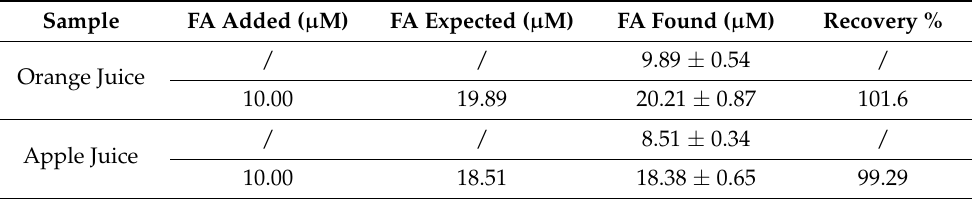
Table 3. Real sample analysis of FA using PE/CuO-CNTs/BDHFP (n = 4) [52].